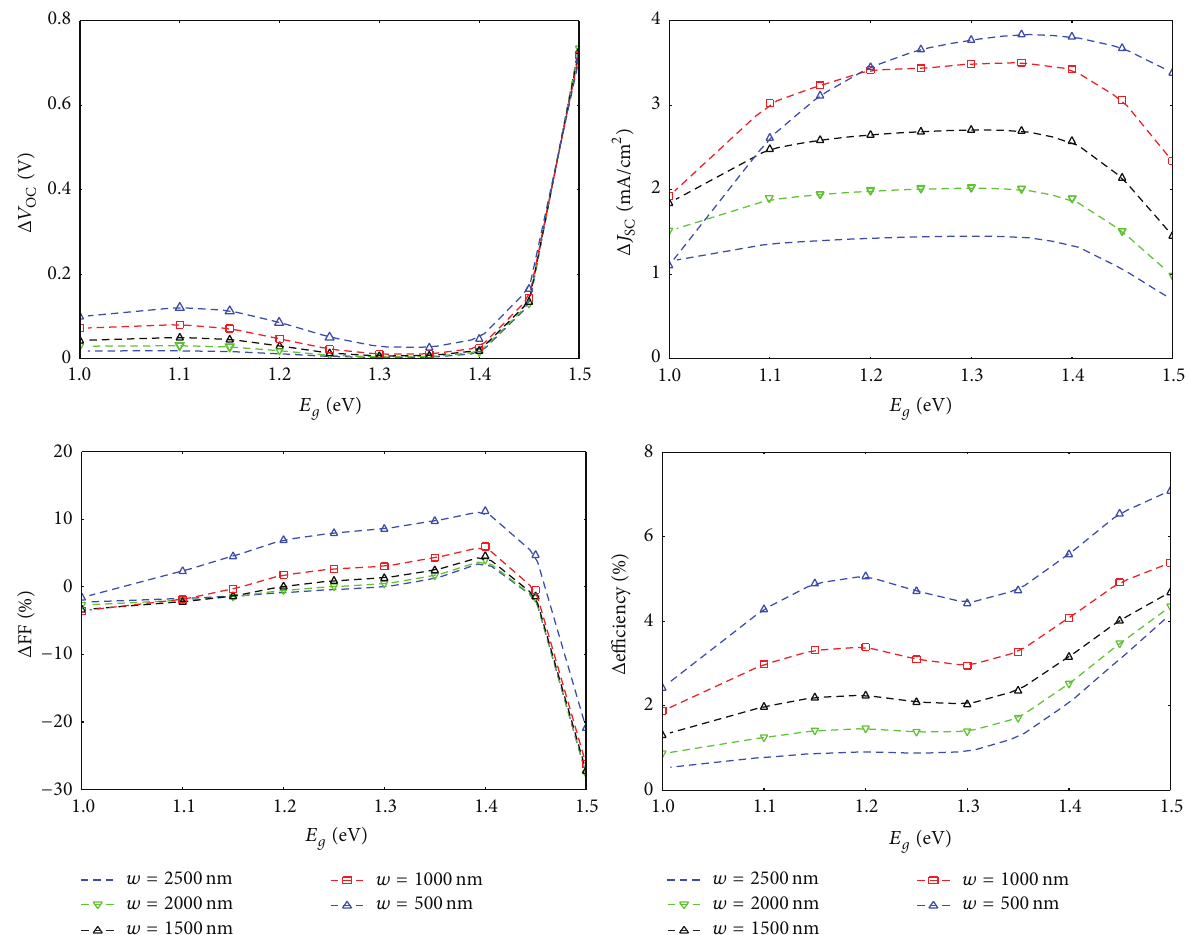
Figure 7: Gain of electrical parameters due to presence of the